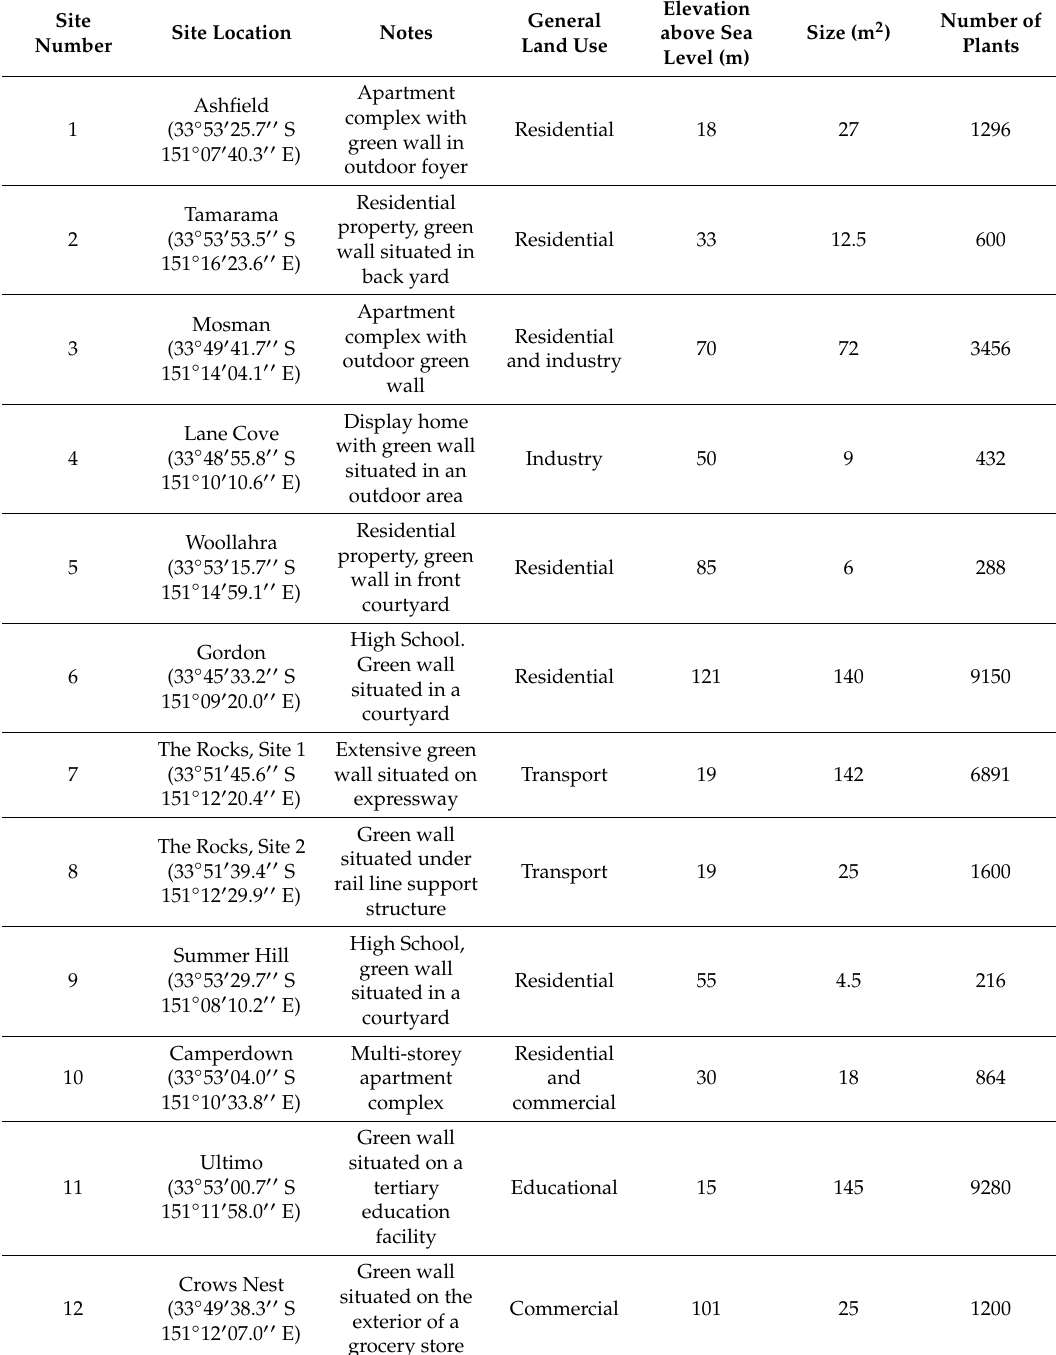
Table 1. Test site location